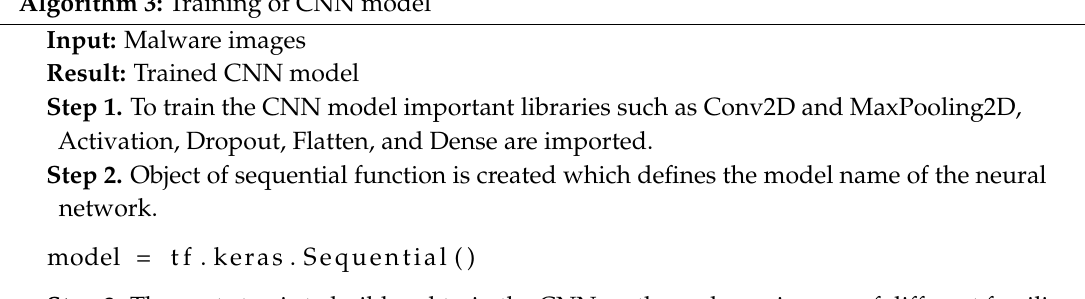
Algorithm 3: Training of CNN